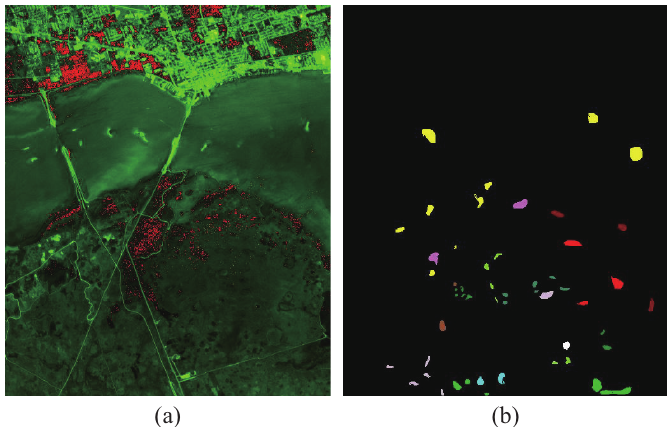
Figure 8. Kennedy Space Center (KSC) data set. ( a ) Pseudocolor image. ( b ) Ground-truth map.